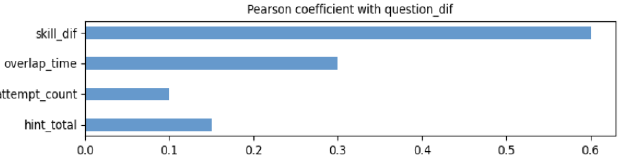
Figure 2. Correlations between different characteristics.